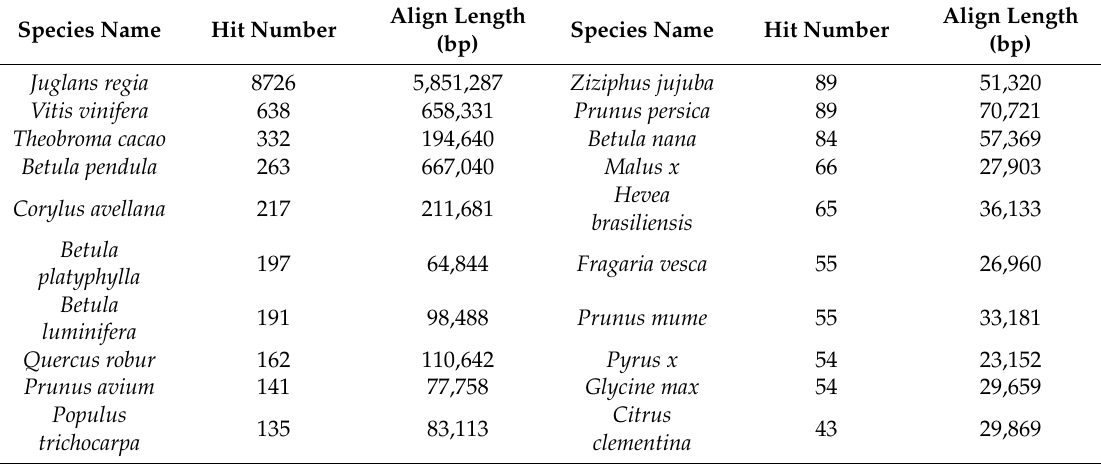
Table 5. Species distribution of contigs of B. platyphylla tissue culture